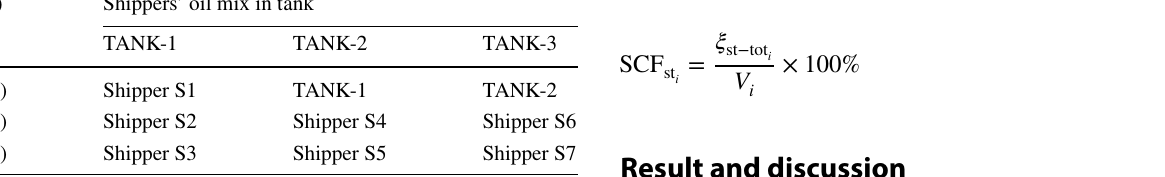
Table 10 Notes of Table 9: stratification of oil mix in tank ( i